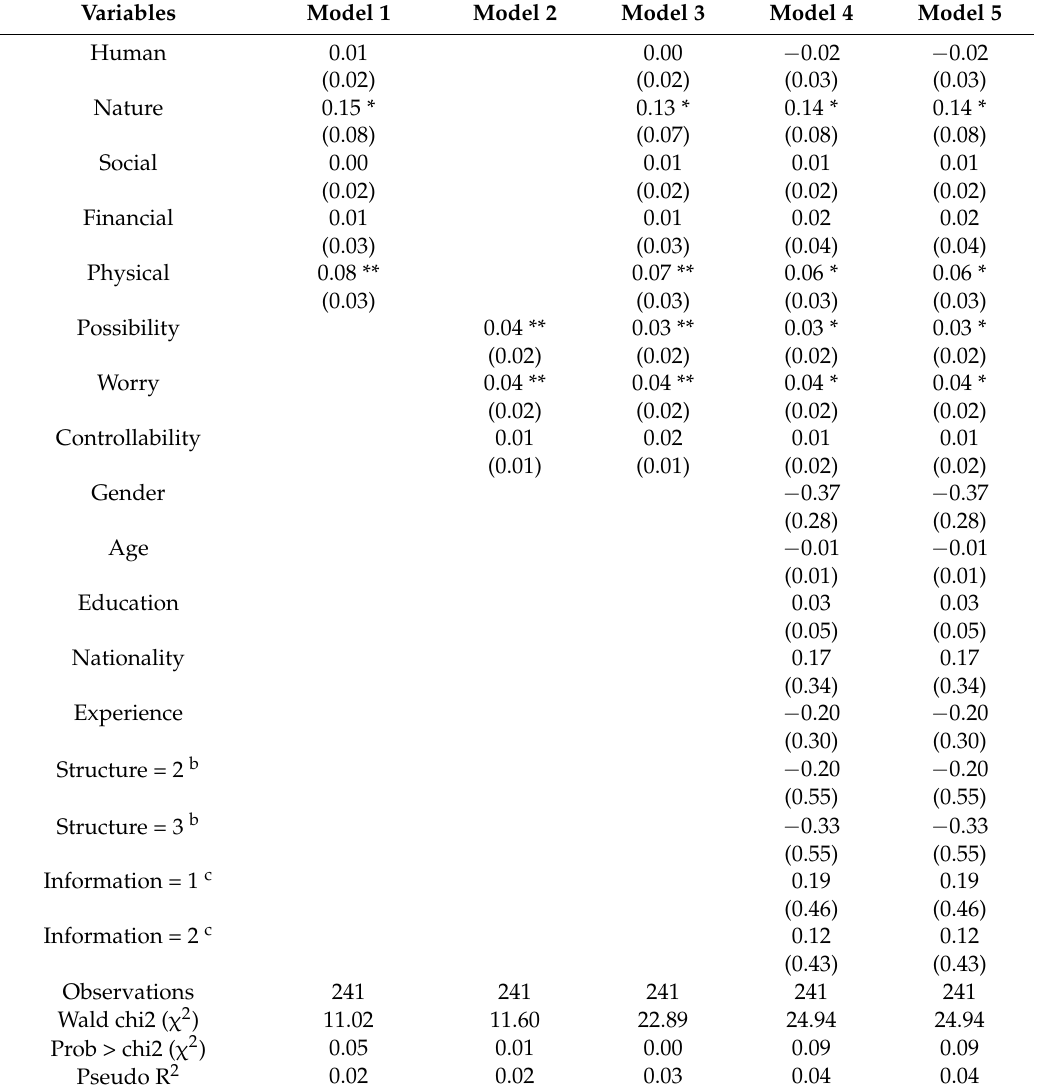
Table 6. Results of regression estimates of households’ willingness to purchase earthquake disaster insurance a